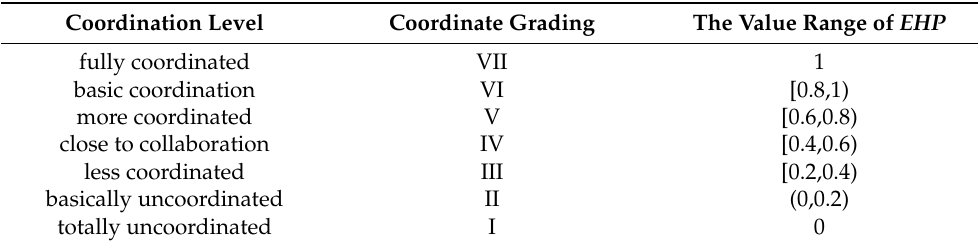
Table 1. The grades of the coordination index of public health and high-quality development in the Yellow River Basin. Coordination Level Coordinate Grading The Value Range of EHP fully coordinated basic